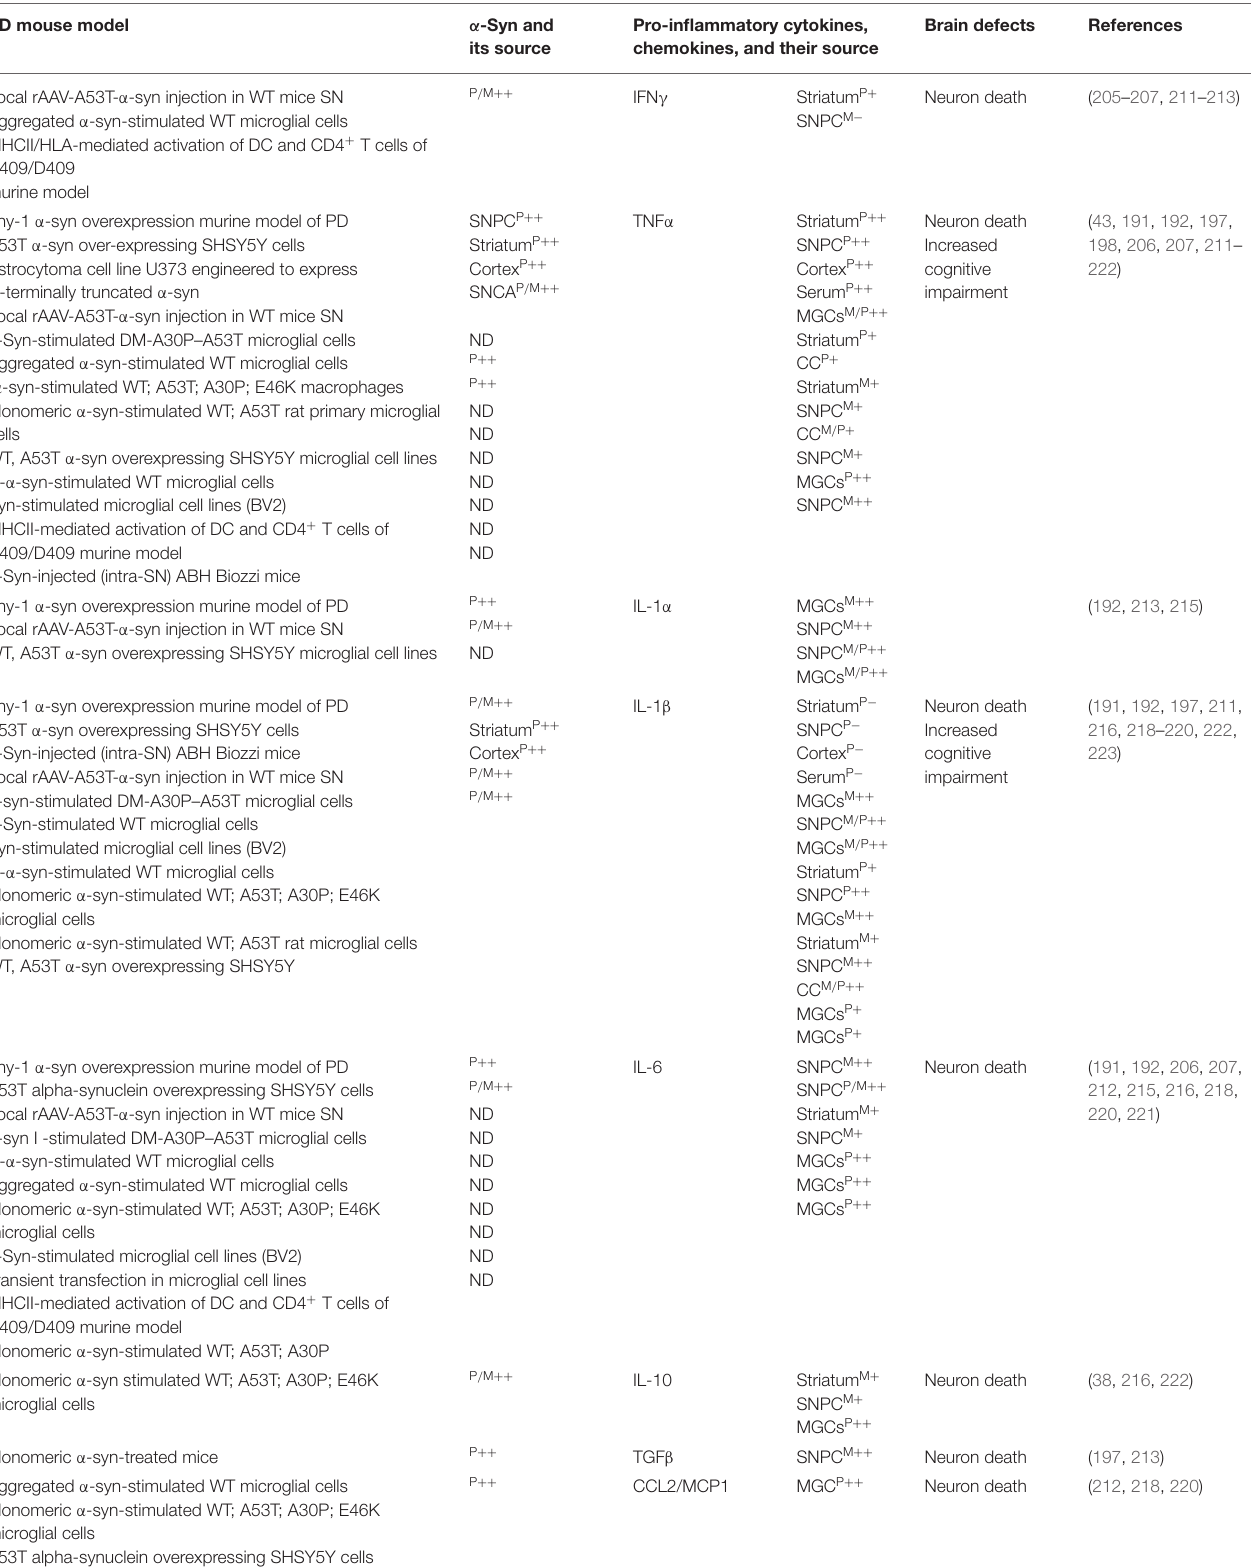
TABLE 4A | Cytokines and their source in the mouse model of SNCA PD. PD mouse